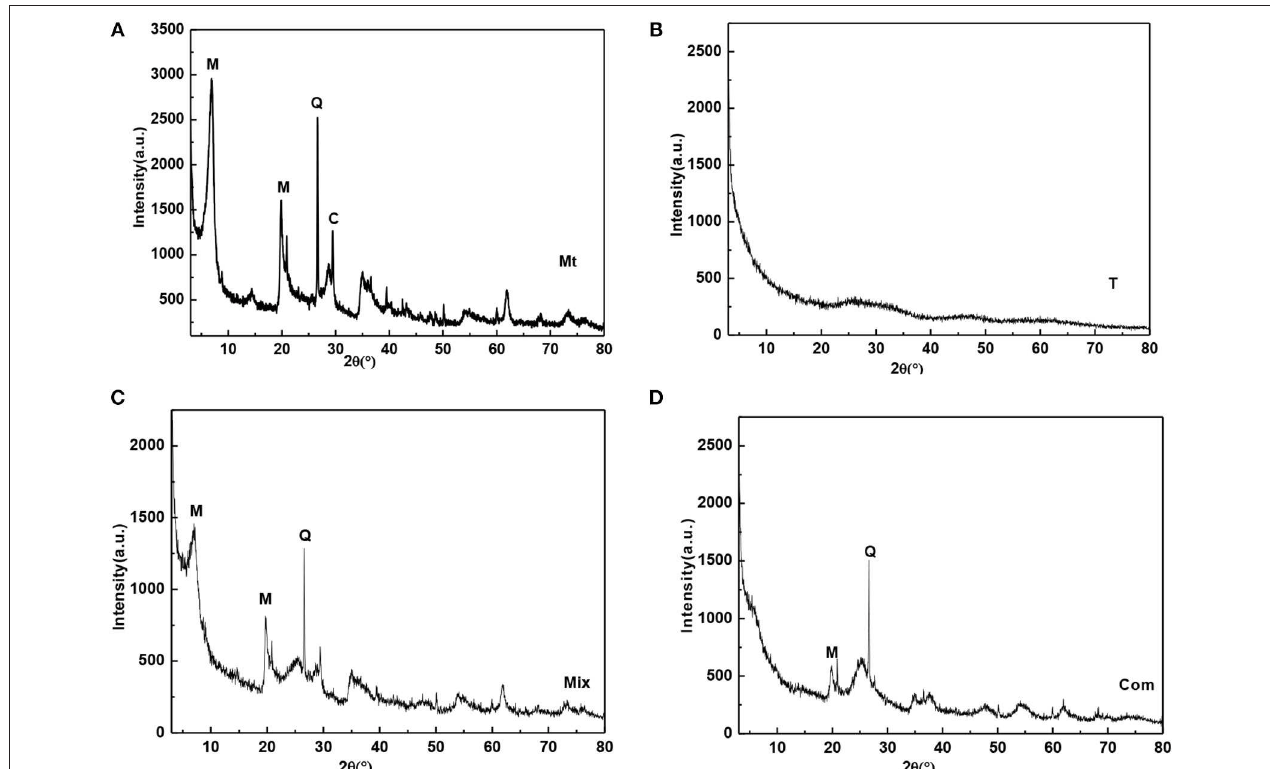
FIGURE 1 | XRD patterns of (A) Mt, (B) T, (C) Mix, and (D) Com (M-montmorillonite; Q-quartz;